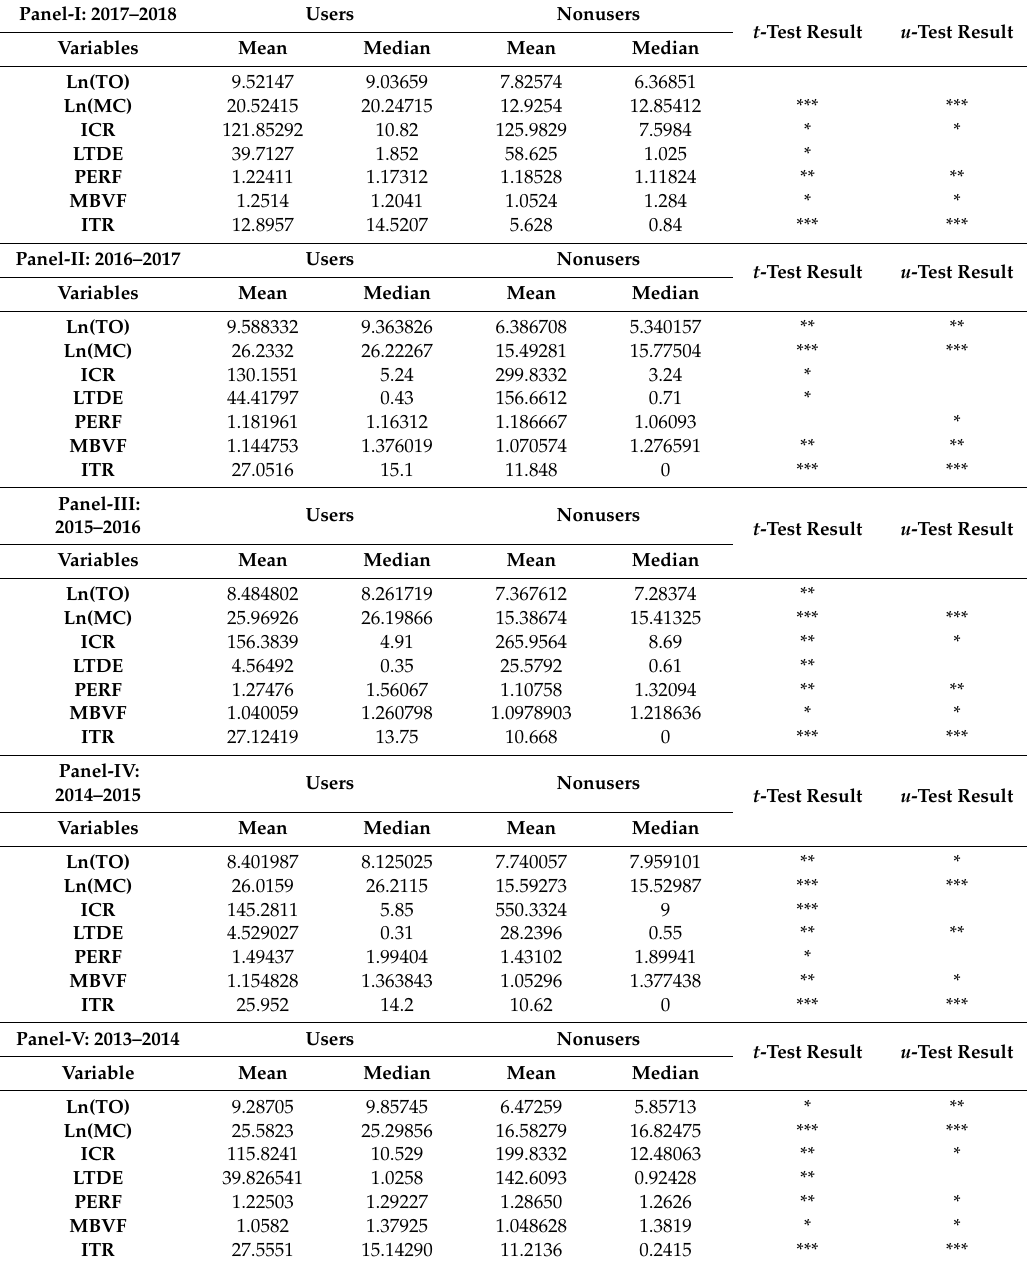
Table 1. Comparison of financial indicators through t -test and u -test results between users and nonusers of financial